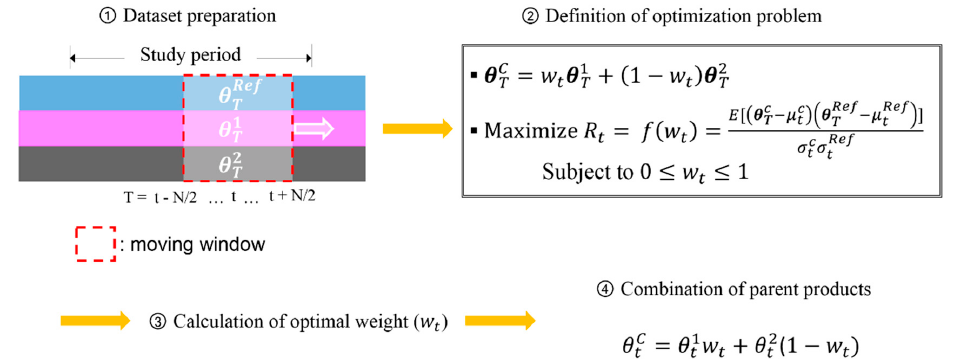
Figure 2. Schematic diagram for dynamic linear combination. T denotes the period defined by the window ( i.e ., T = (t − N/2):(t + N/2)). Therefore, a bold symbol that has T as its subscript means a vector in the period T, and a non-bold symbol with t as the subscript represents a value at the point in time t